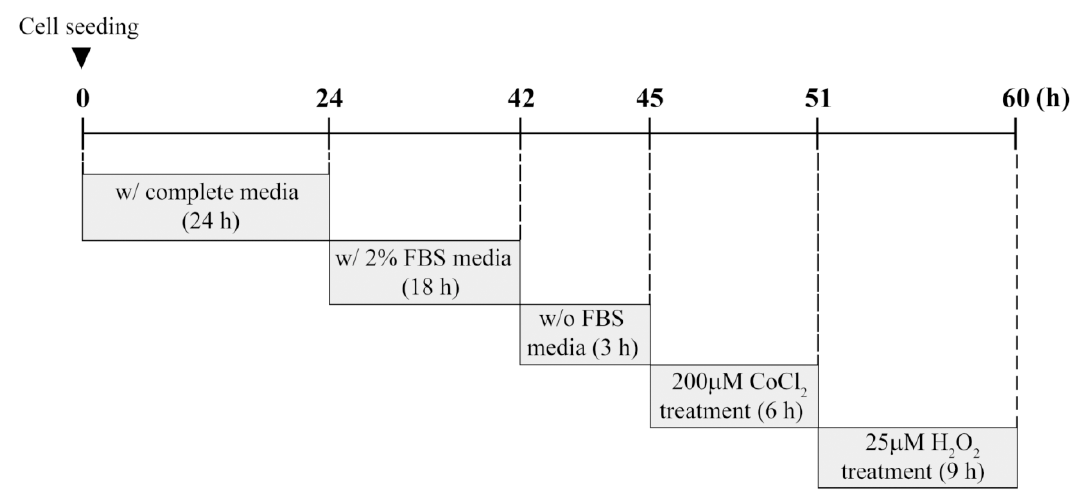
Figure 1. Experimental scheme for preconditioning with CoCl 2 followed by H 2 O 2 treatment.